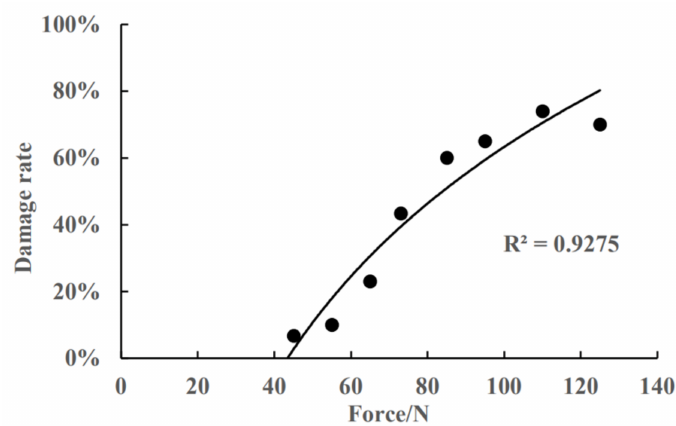
Figure 12. Relationship between fruit damage rate and impact